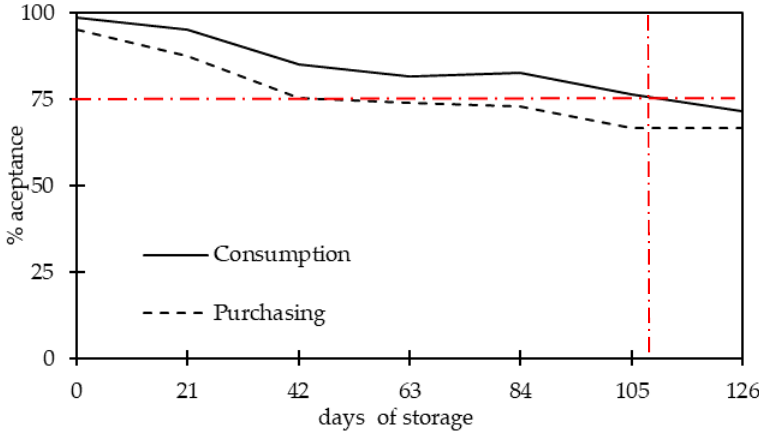
Figure 1. Consumption intention (continuous line) of sliced cured pork loins stored at 6 ± 1 °C for 126 days according to 81 participants. Purchasing intention (dashed line).